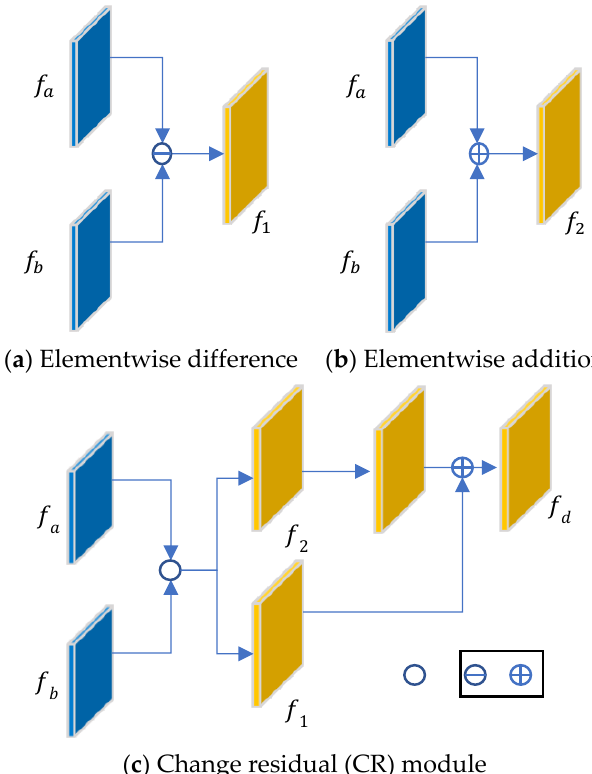
Figure 7. Single scale changed feature generation.